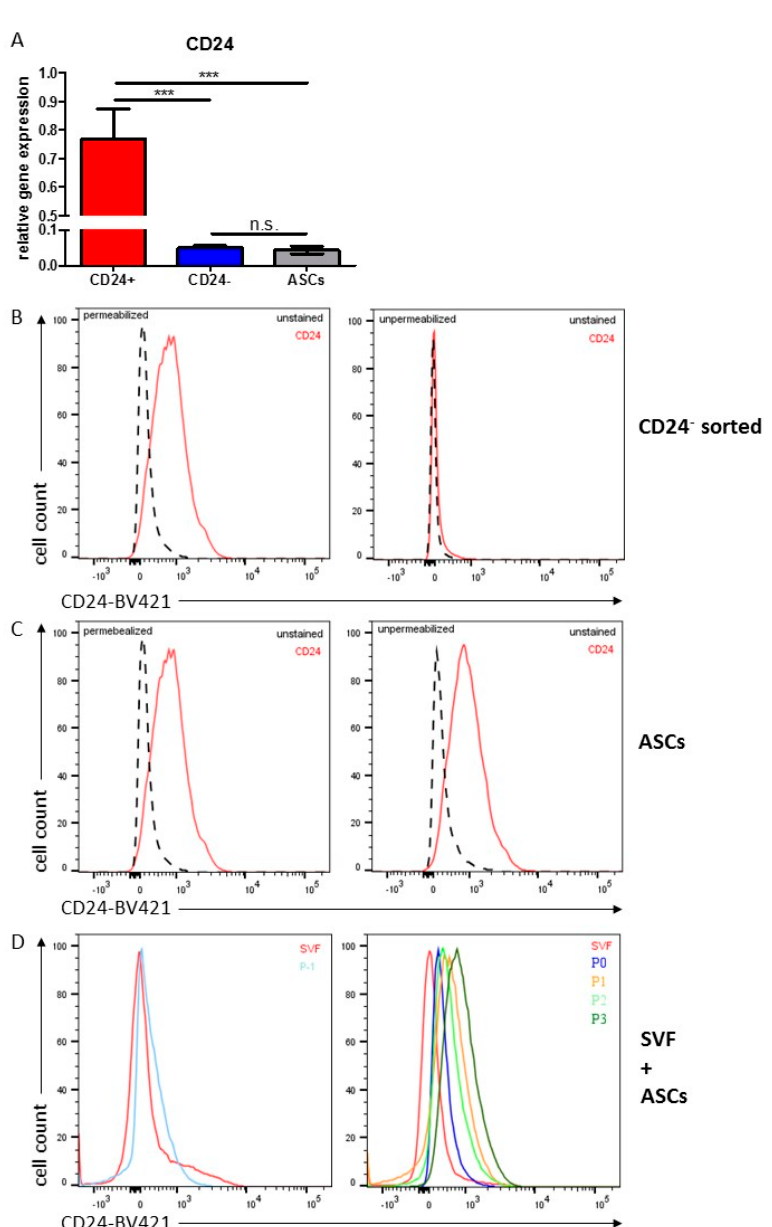
Figure 5. CD24 Expression in ASCs. ( A ) CD24 gene expression in sorted CD24 + and CD24 − ASCs as well as in cultivated ASCs, routinely isolated by the plastic-adherence protocol. Merged data from 4 different donors are shown, gene expression was normalized to RPS18, n = 3 for technical replicates. Mean+SEM is shown, unpaired student´s t-test was performed to calculate significances with *** p < 0.001. ( B , C ) Intracellular (left panel, permeabilized) and cell-surface (right panel, unpermeabilized) CD24 protein level measured by FACS for ( B ) sorted CD24 − cells and ( C ) unsorted cultivated ASCs routinely isolated by the plastic-adherence protocol at passage 2. Unstained control (black, dashed lines) and CD24 stained cells (red, solid lines) are shown. ( D ) CD24 cell-surface expression measured by FACS on ASCs in the course of routine isolation by the plastic-adherence protocol and cultivation. (Left panel) Unsorted SVF cells (red) and plastic-adherent cells after cultivation for 6 days in serum-free ASC1 medium (P-1, light blue) are shown. (Right panel) SVF cells are shown in red. P-1 cells further cultivated for 1 week in serum-containing PM4 medium were referred to as P0 and are shown in dark blue. After freezing, these cells were re-thawed, taken into culture and referred to as ASC passage 1 (P1, orange) and further cultivated to passage 2 (P2, light green) and passage 3 (P3, dark